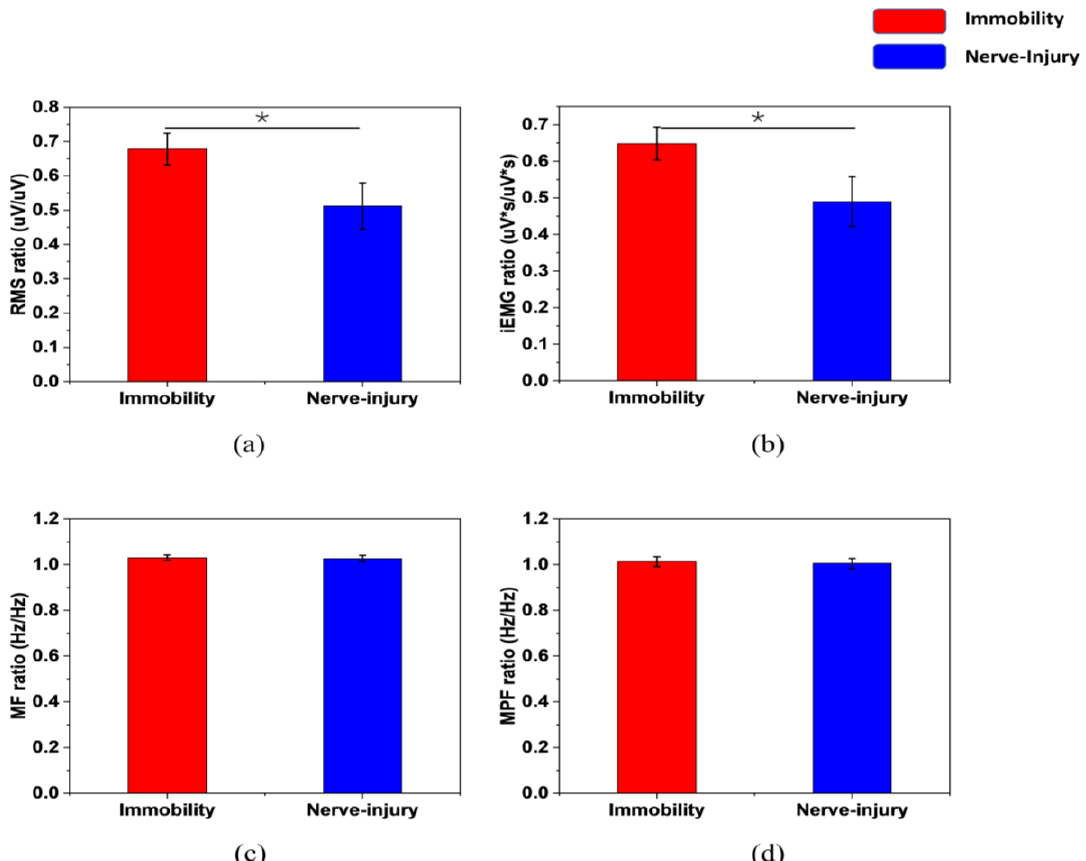
Figure 4. The sEMG features distribution of ( a ) RMS, ( b ) iEMG, ( c ) MF, ( d ) MPF between two categories. (* p < 0.05).